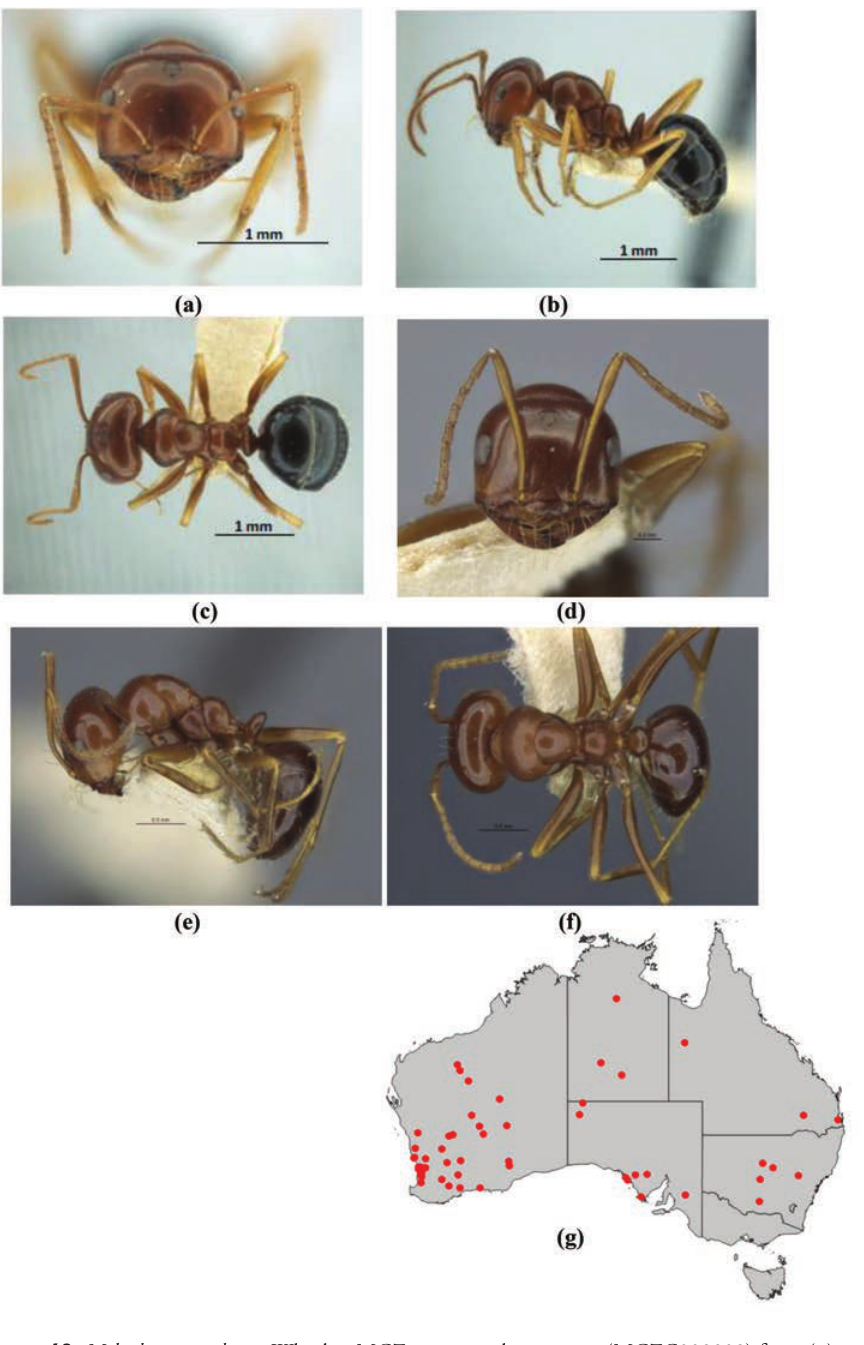
Figure 68. Melophorus perthensis Wheeler: MCZ major worker syntype (MCZC002302) frons ( a ), pro- file ( b ) and dorsum ( c ); MCZ minor worker syntype (MCZ-ENT00303602) frons ( d ), profile ( e ) and dorsum ( f ); distribution map for the species ( g ). Low resolution scale bars: 0.5 mm ( e, f ); 0.5 mm ( d